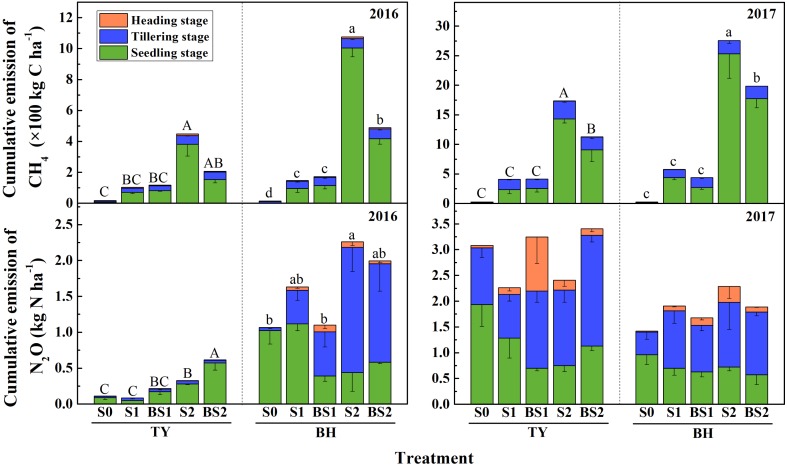
Cumulative emissions of CH4 and N2O over the rice growing season in 2016 and 2017. Colors in column denote different stage: the seedling stage in green, the tillering stage in blue and the heading stage in orange. Error bars present standard deviation of means (n = 3). The different letters (capital letter for the TY soil and lowercase for the BH soil) among different treatments indicate significant difference of the cumulative emissions during the whole rice growing season, which was analyzed by Duncan’s multiple range test (P < 0.05).